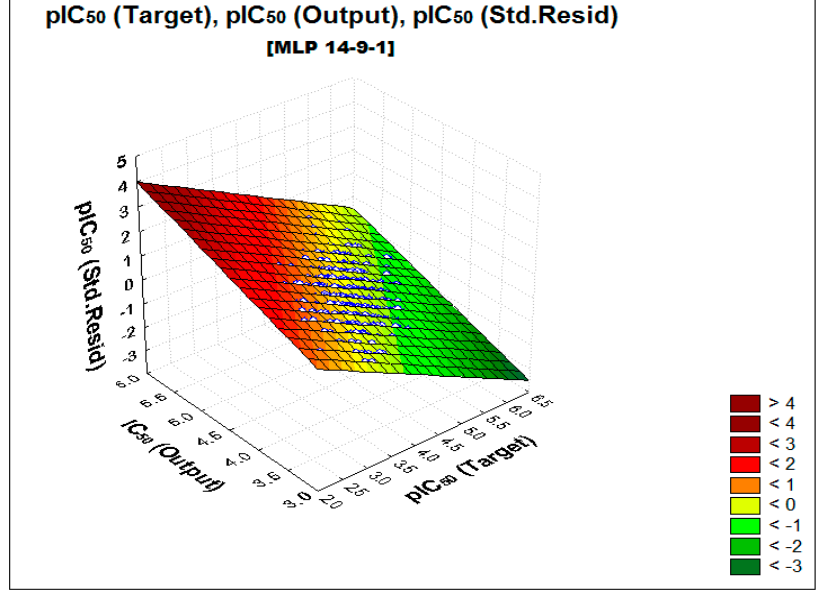
Figure 1. Regression plane of relation between targets, output and standard residuals values of the analyzed variable (pIC 50 ).